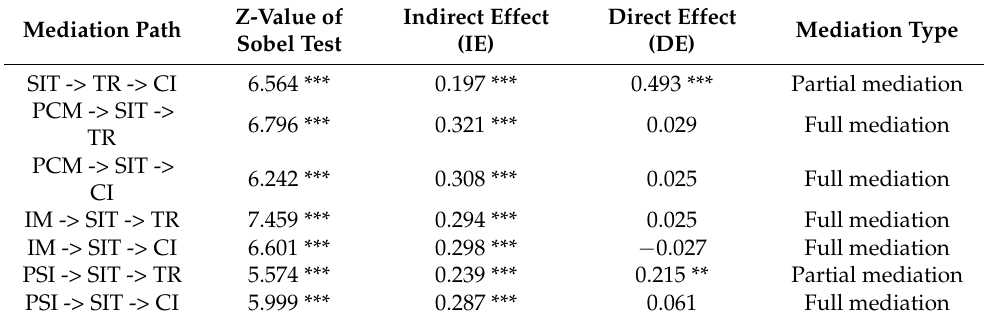
Table 7. Path coefficients and its